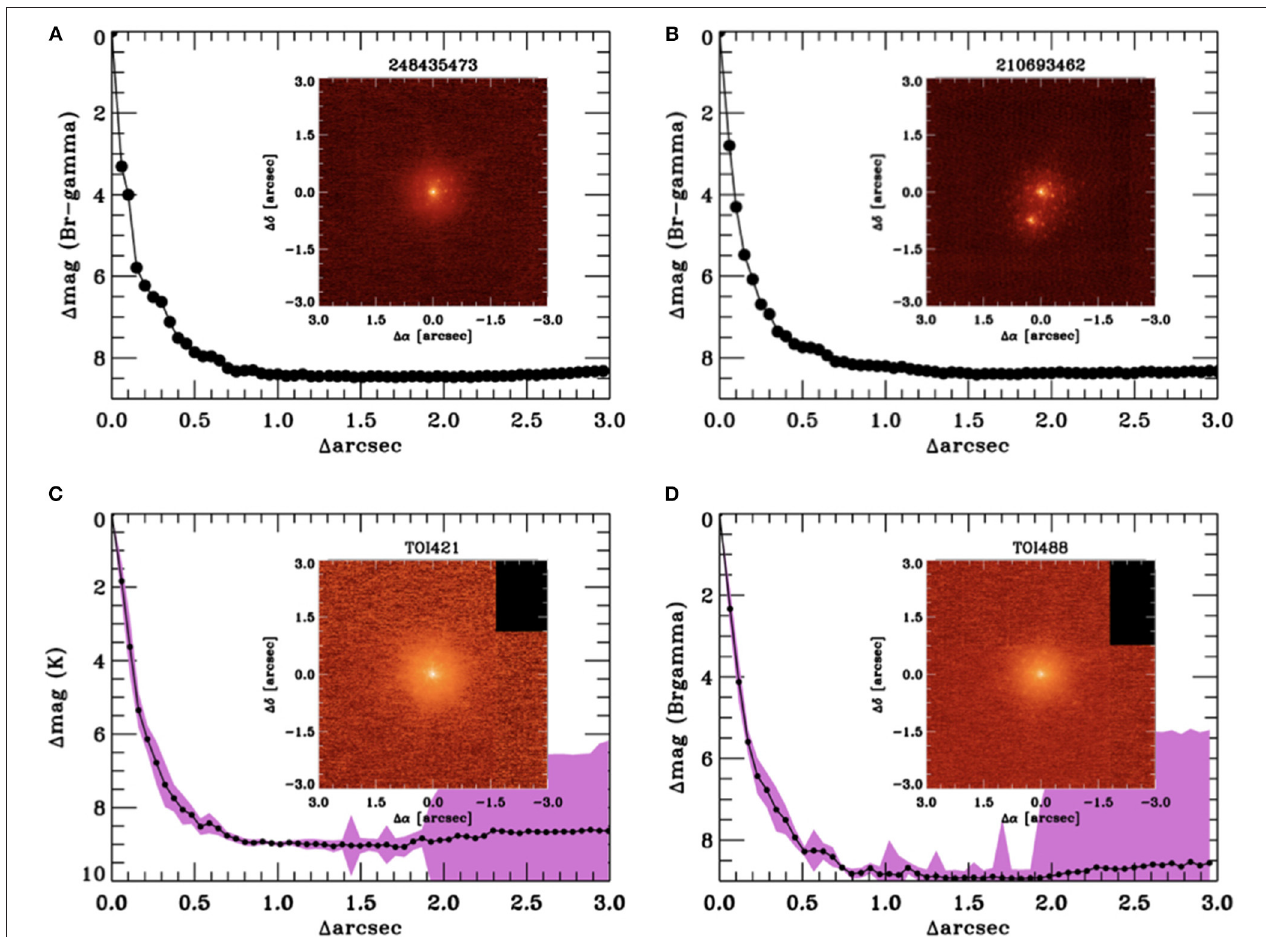
FIGURE 1 | High-resolution images and 5 σ contrast curves of stars hosting validated transiting exoplanets obtained in this Keck AO imaging program. (A) Br- γ observations of K2-266 (EPIC 248435473, Rodriguez et al., 2018). (B) Br- γ observations of K2-288 (EPIC 210693462, Feinstein et al., 2019). The observations revealed a faint companion to the southeast, K2-288B, that likely hosts the exoplanet. (C) K-band observations of TOI-421 (Carleo et al., 2020). (D) Br- γ observations of GJ 3473 (TOI-488). In (C,D) , the shaded regions represent the uncertainties in the contrast sensitivity estimates described in the text. Once processed, these contrast curves with reduced image insets are available for all targets observed in this program via the ExoFOP website. (A–C) are reproduced with permission of the